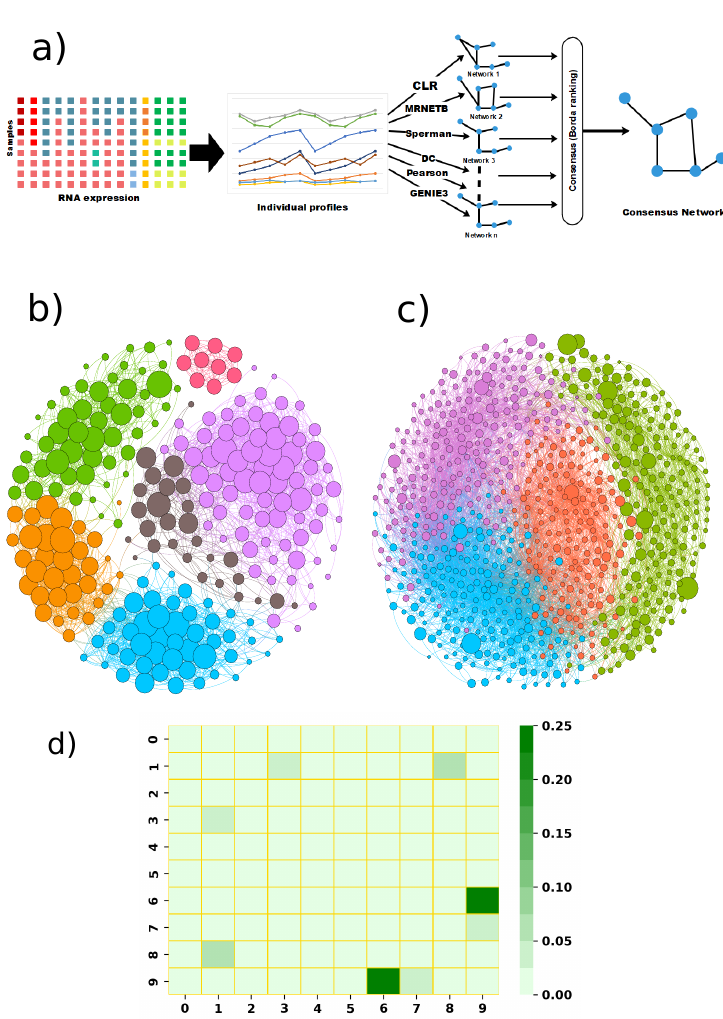
Figure 5. ( a ) Flowchart of gene co-expression network prediction from RNA-seq data; ( b ) gene co-expression network for AD. The six identified clusters are marked with different colors. Node size represents page-rank centrality (larger value means that the gene is more important in that cluster) of each gene. ( c ) Gene co-expression network for PD. The four identified clusters are marked using different colors. ( d ) Functional similarity between identified functionally-enriched clusters between AD and PD. The similarity of clusters was calculated using the Jaccard similarity (see the Methods). Here, Clusters 0–5 are identified as AD clusters, and 6–9 are identified as PD clusters. Darker green color corresponds to higher similarity between